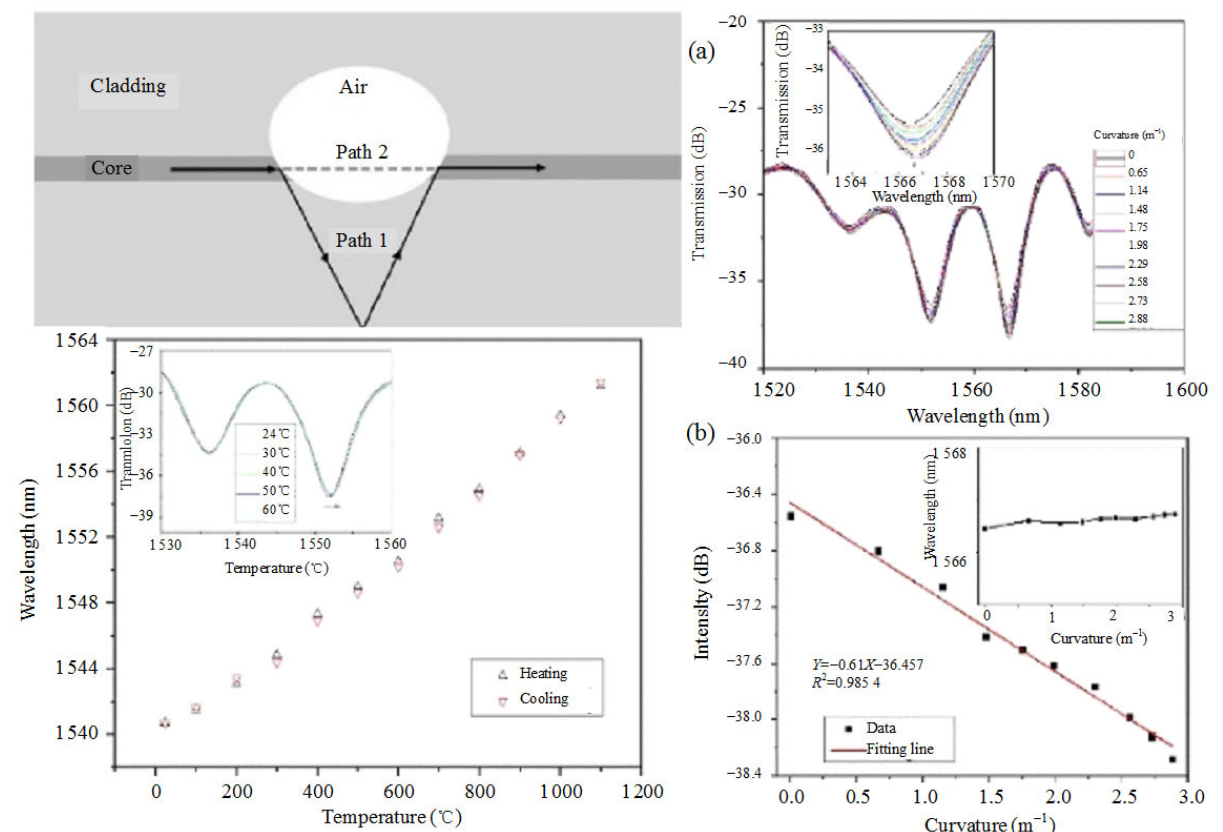
Fig. 23 Schematic diagrams of the fiber MZI based on a sealed air hole and its temperature, RI, and curvature response